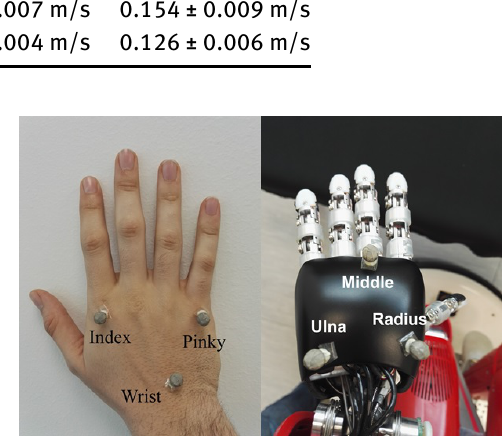
Figure 2: Motion capture markers. Positioning is different between subject and robot in order to distinguish them better during the data analysis